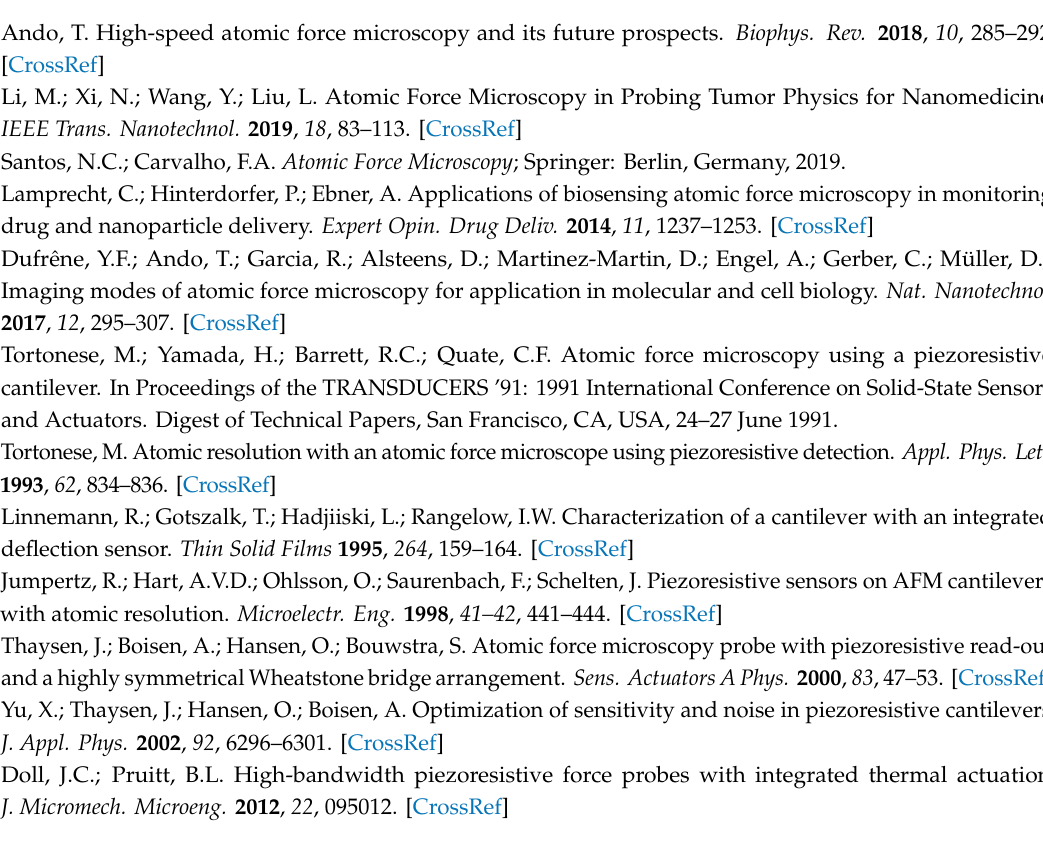
Figure S1: Comparison of electrical and optical readout, Figure S2: Comparison of AE-AFM speed measurements at di ff erent environmental